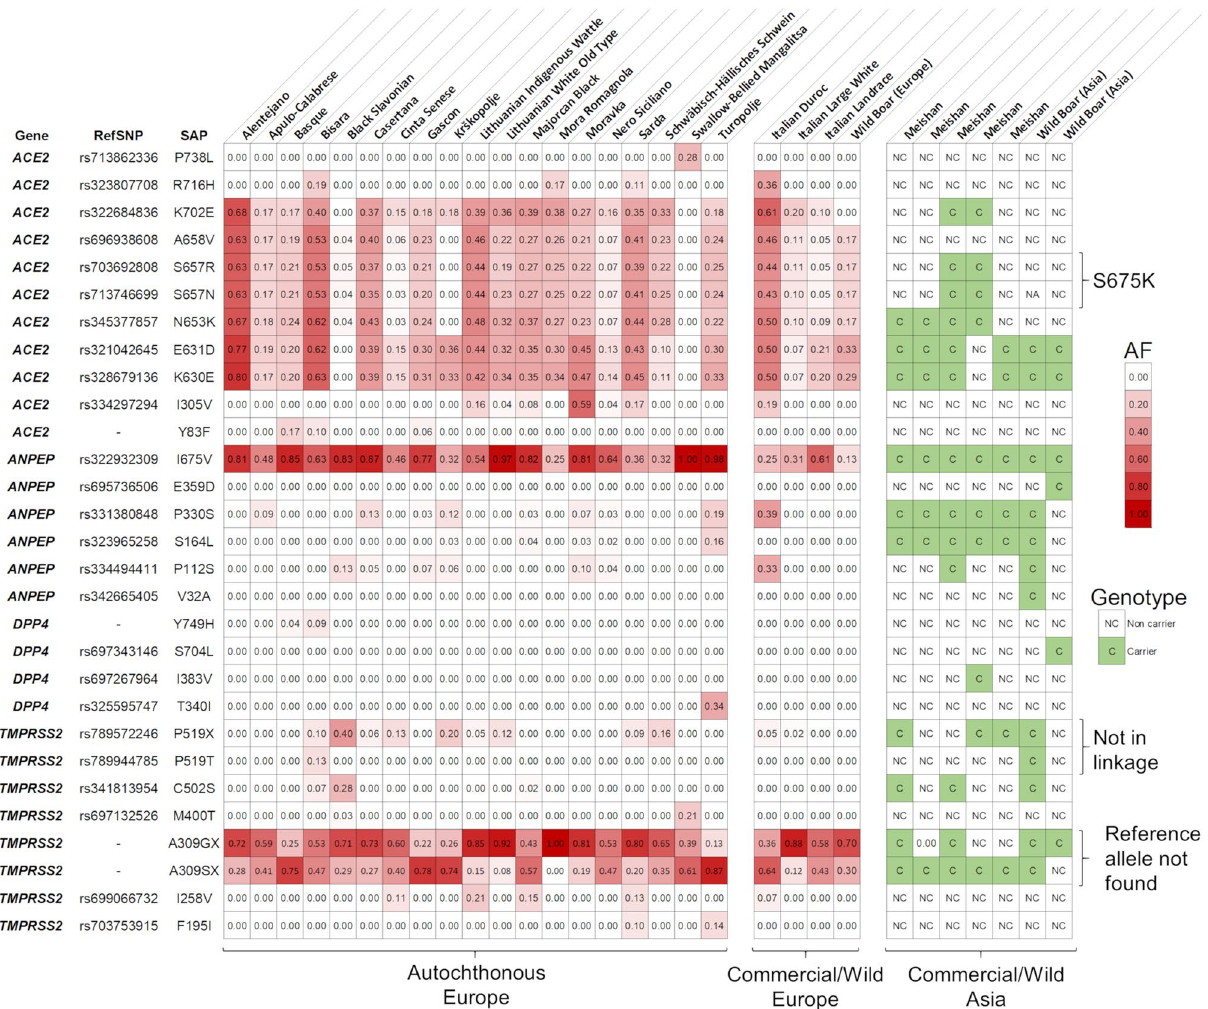
Figure 4. Frequency and genotype information related to the alternative allele of the variants affecting the protein of the four candidate genes ( ACE2 , ANPEP , DPP4 and TMPRSS2 ) in the 23 European and two Asian populations (autochthonous pig breeds, commercial pig breeds and wild boars). Detailed information is provided in Supplementary Table S8. Information for the European breeds and wild boars is obtained from the sequenced DNA pools. Information for the Asian populations is obtained from whole genome sequencing data of individual animals and the right part of the figure reports the carrier status of the alternative